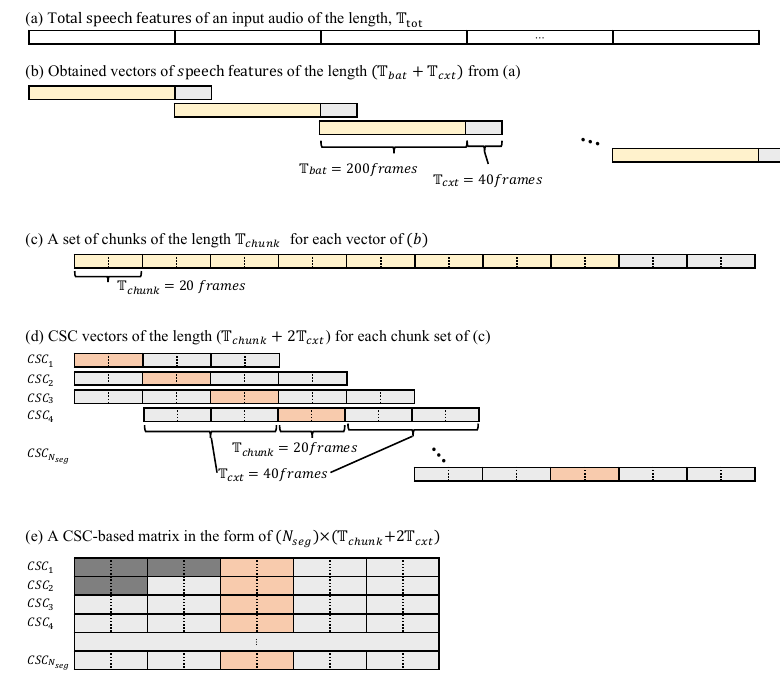
Figure 2. Context-sensitive-chunk (CSCs) of our ASR system with T bat of 200 frames, T chunk of 20 frames, and T cxt of 40 frames: ( a ) extracted speech features from the overall input sequence, ( b ) a set of speech feature vectors where each vector is obtained from R feat and the size is ( T bat + T cxt ), ( c ) a set of chunks where the chunk size is T chunk , ( d ) a set of CSCs where the CSC size is ( T cxt + T chunk + T cxt ), and ( e ) a CSC matrix for a speech feature vector.